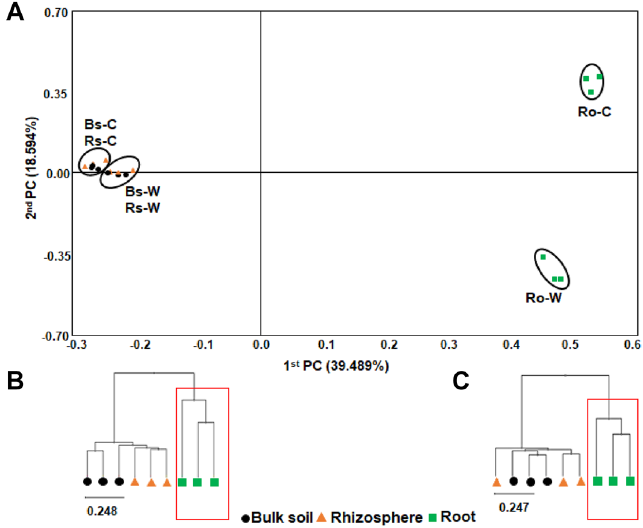
Figure 2. Principal coordinates analysis (PCoA) and UPGMA clustering of bacterial composition. ( A ) PCoA and UPGMA clustering based on Bray–Curtis dissimilarity in ( B ) wild and ( C ) cultivated areas using relative abundances of all OTUs at the species level. The red box shows the cluster formed exclusively in roots of both wild and cultivated habitats.